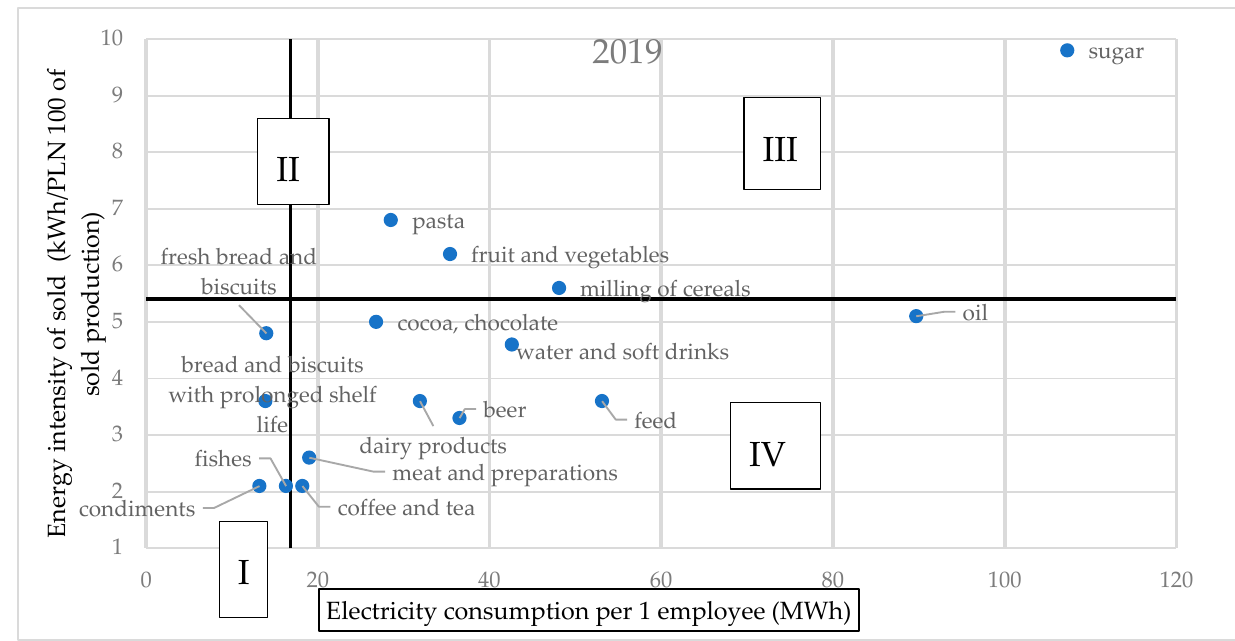
Figure 4. Distribution of selected food-industry production activities according to electricity con- sumption per PLN 100 of sold production and per employee in 2019. Source: own elaboration.